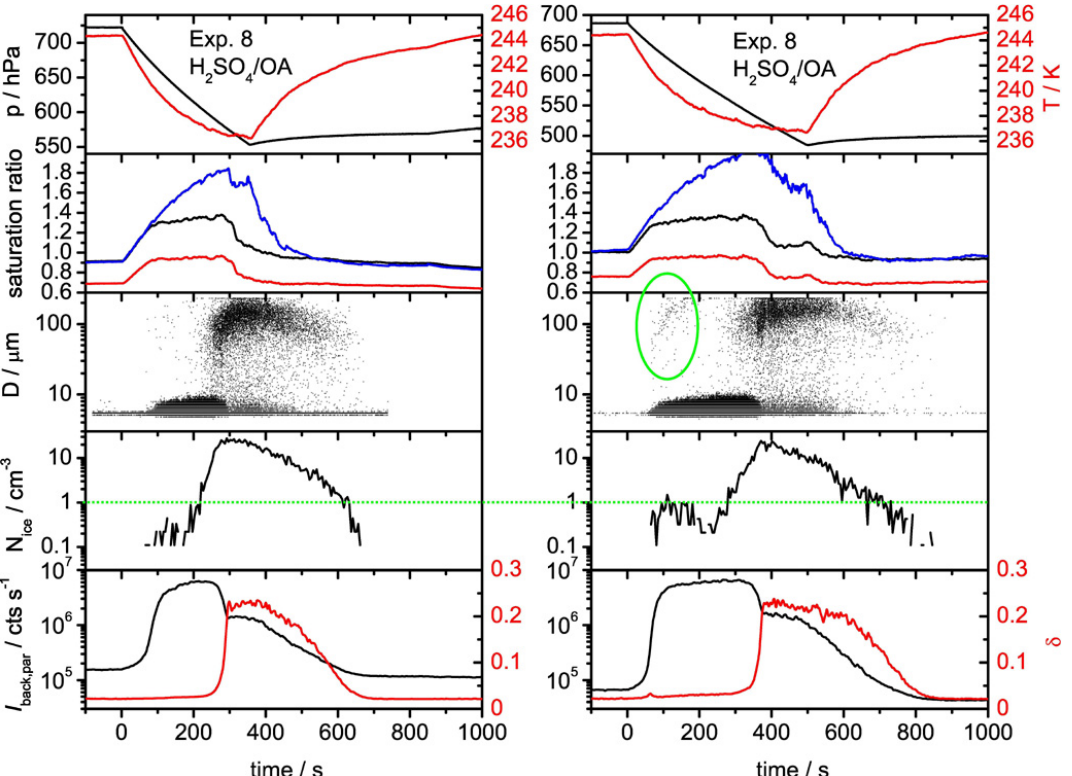
Fig. 16. Time series of various AIDA records during two expansion cooling cycles from Exp. 8 that were started at 244K. The individual panels show the same measurements as in Fig.